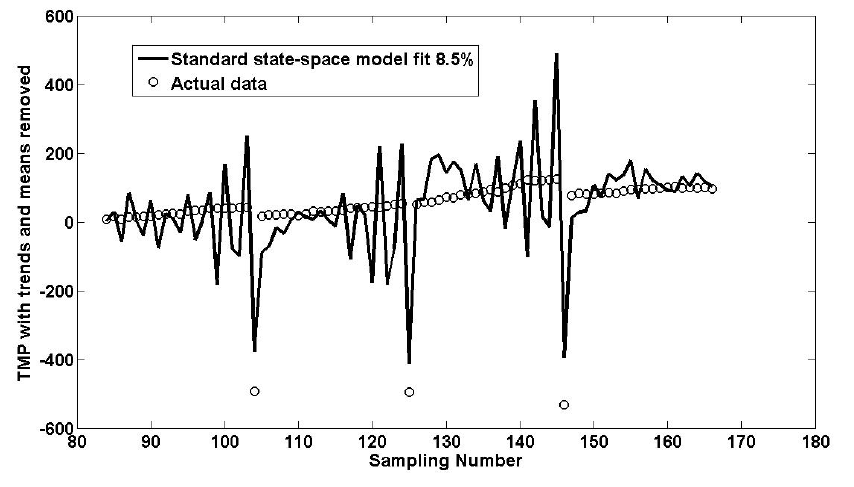
Figure 3. Best model fit for 8 flux steps (4 for validation) for standard state-space